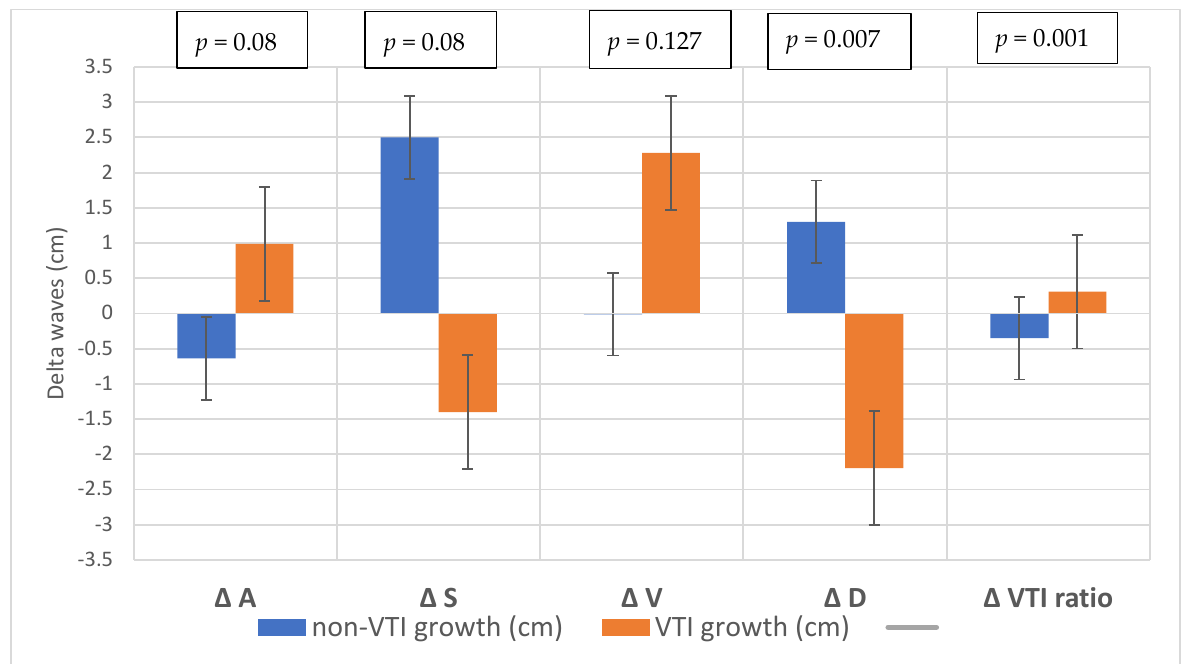
Figure 6. Changes in the waves during the preoperative – postoperative period.